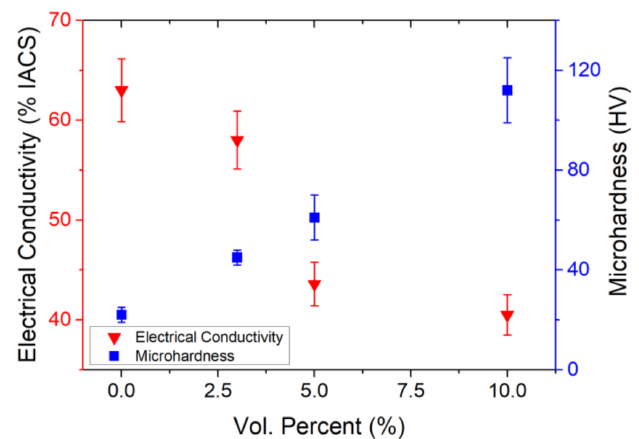
Figure 2. Effect of TiB 2 nanoparticles on mechanical and electrical properties of Al–TiB 2